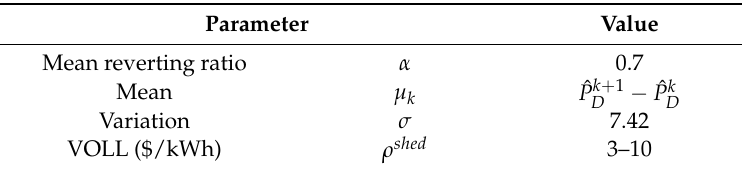
Table 2. Parameters for the stochastic process and value of lost load (VOLL).